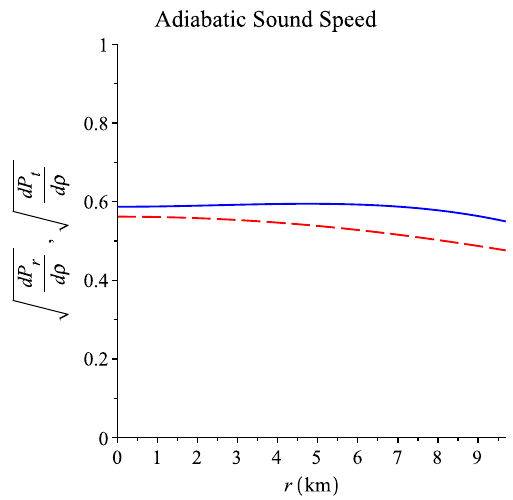
Fig. 5 Plot of energy density gradient κ d ρ/ d r (Eq. (7.2.5)) for the parameter values used in Fig. 1